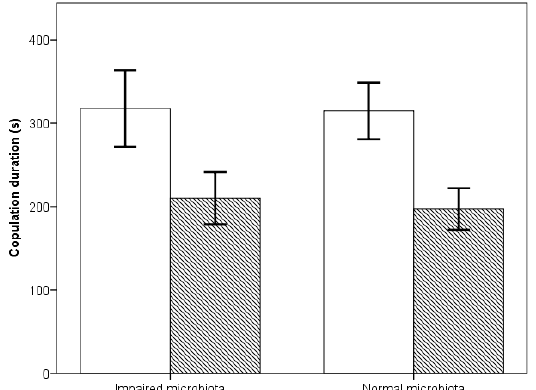
Figure 2. Mean copulation duration and 95% confidence intervals of old (open bars) and young (hatched bars) males, with either their microbiota impaired or intact when placed with a single female.